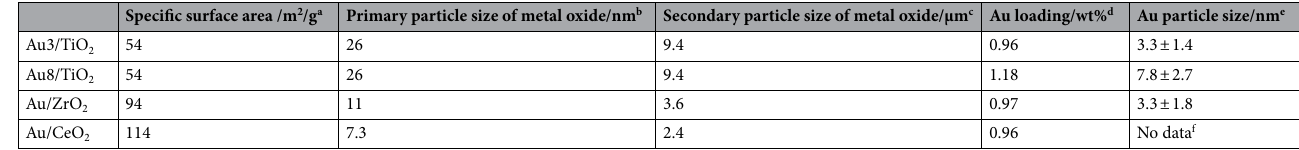
Table 1. Physicochemical properties of Au NPs supported on metal oxides. a Specific surface area of metal oxide was calculated from N 2 adsorption isotherms using the Brunauer–Emmett–Teller (BET) method. b Primary particle size of metal oxide was estimated from the specific surface area. c Secondary particle size of metal oxide after the deposition of Au NPs was measured by dynamic laser scattering. d Actual loading amount of Au was determined by inductively coupled plasma-atomic emission spectroscopy (ICP-AES) or atomic absorption spectrometry (AAS). e Average particle size of Au NPs on metal oxides were estimated by HAADF- STEM. f Majority of Au species was considered to be atomically dispersed on CeO 2 and could not be detected due to a limitation of resolution and low contrast between heavy Ce and Au atoms by